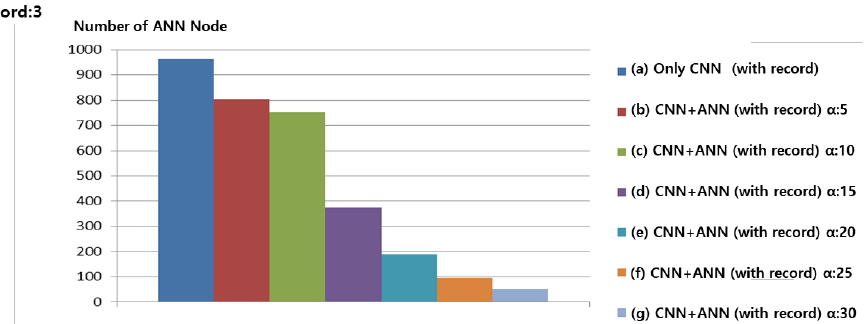
Figure 11. Number of ANN Nodes when Record was three.